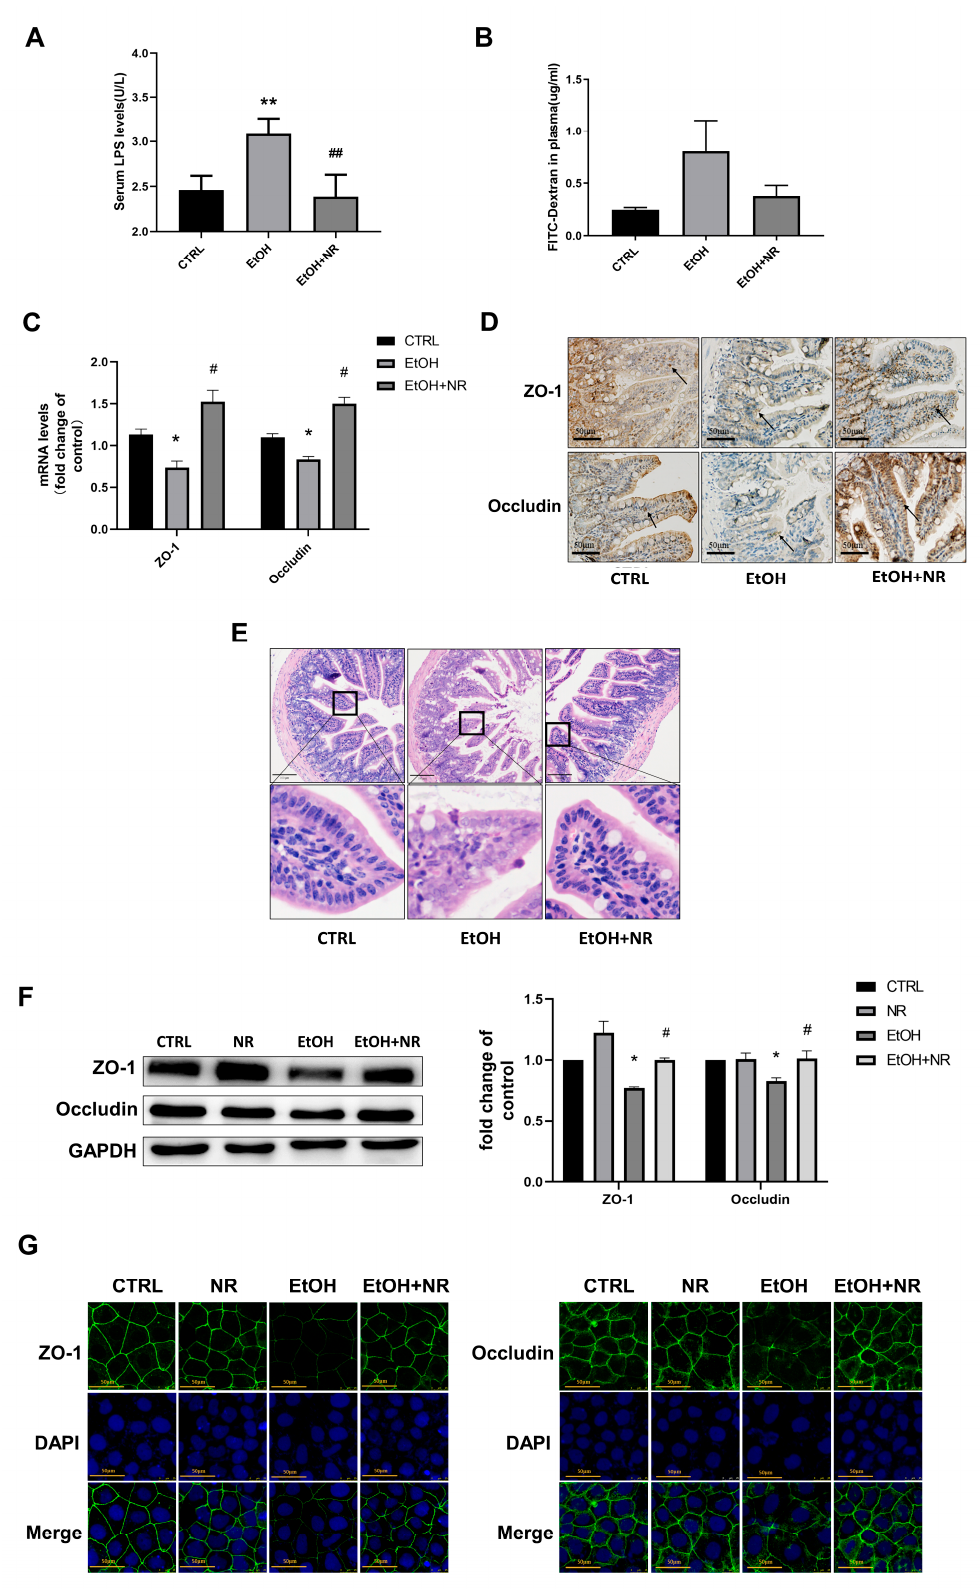
Figure 1. NR supplementation alleviates ethanol-induced intestinal barrier dysfunctions both in in vivo and in vitro experiments. ( A ) The Serum LPS levels after sacrifice; ( B ) the plasma FITC- Dextran concentrations after sacrifice of the assessment of in vivo gut permeability; ( C ) relative